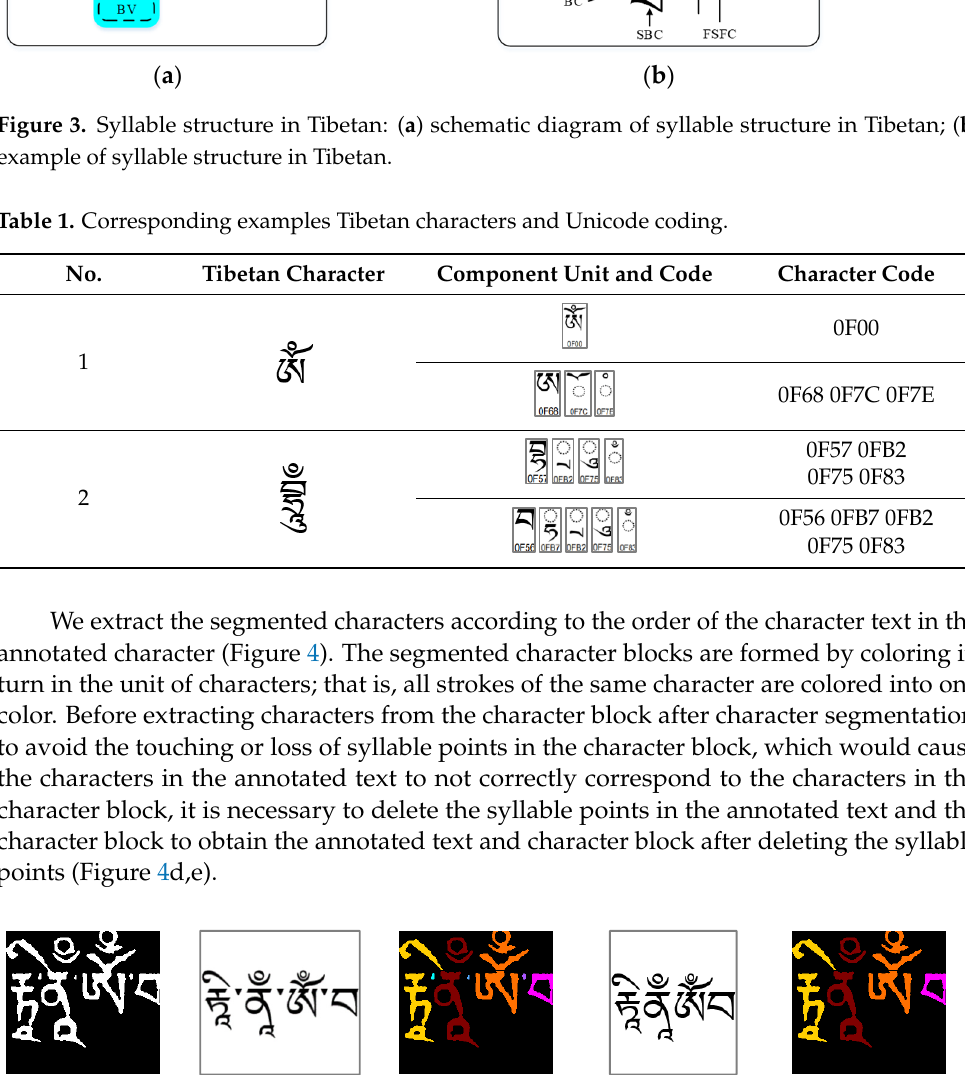
Figure 4. Example of character annotation: ( a ) character block; ( b ) annotated text; ( c ) character block after segmentation; ( d ) annotation after shielding syllable points; ( e ) character block after shielding syllable points.